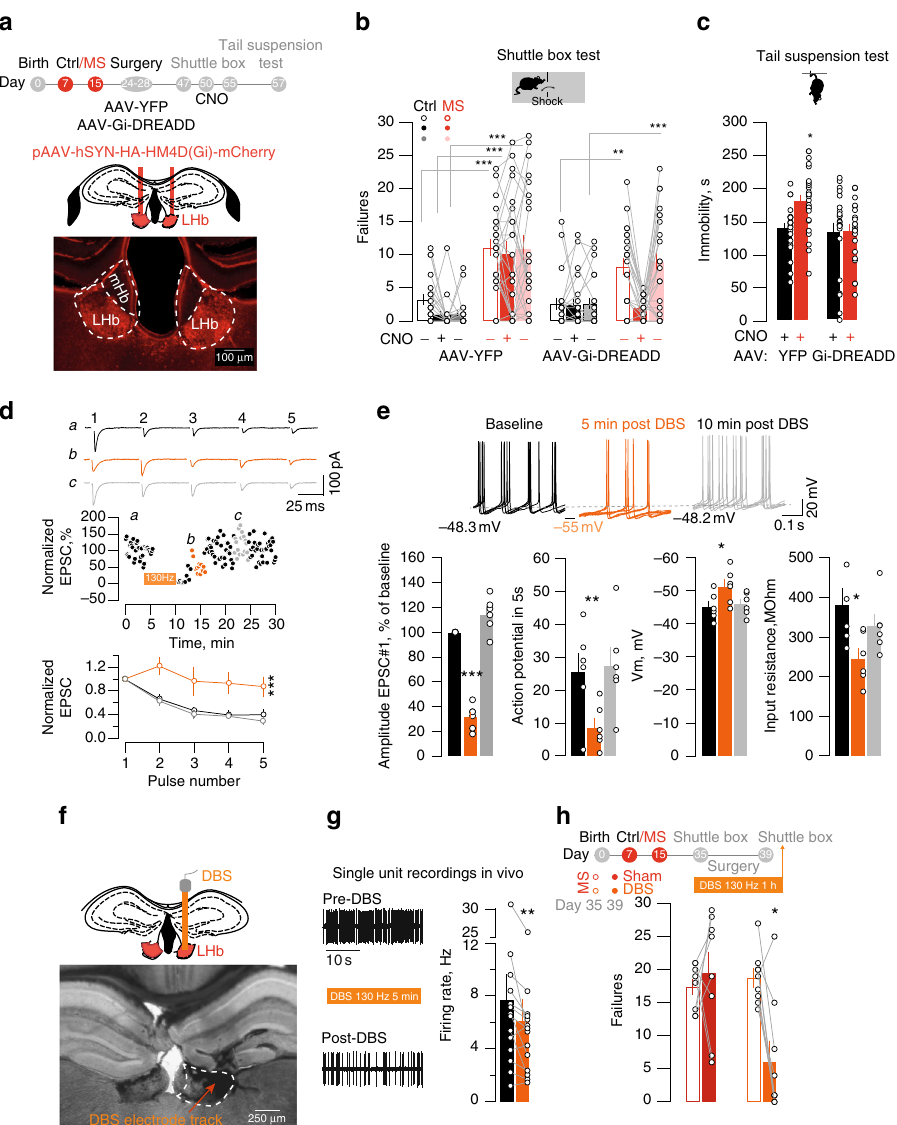
Fig. 4 Chemogenetic and DBS approaches reduce LHb activity and ameliorate MS-dependent depressive-like symptoms. a Schematic and image for Gi- DREADD LHb expression. b CNO effects on failures in the shuttle box (AAV-YFP, Ctrl vs. MS and AAV-Gi-DREADD, Ctrl vs. MS; n mice = 21/22/23/26; two-way ANOVA RM, interaction, F (6,176) = 3.29, ** p < 0.01). c Bar graph and scatter plot for TST immobility (AAV-YFP and AAV-Gi-DREADD, Ctrl vs. MS: n mice = 23/25/25/ 25; two-way ANOVA, interaction, F (1,94) = 4, * p < 0.05). d DBS effect on 1st EPSC and PPR (5 pulses, 20 Hz. Normalized eEPSC post-DBS, n mice = 2; n cells = 6; One-way ANOVA RM; F (1.23,6.13) = 99.65, *** p < 0.001; Normalized EPSCs, n mice = 2; n cells = 6; Two-way ANOVA RM; DBS effect, F (2,50) = 25.1, *** p < 0.001). e Sample I-clamp recordings (5 superimposed-sweeps), and DBS effects on action potentials, resting membrane potential and input resistance (Before vs. 5 min post-DBS vs. 10 min post-DBS, n mice = 2; n cells = 6: Action potential: F (1.29,6.49) = 13.5, ** p < 0.01; Vm: F (1.15,5.77) = 6.3, * p < 0.05; Ri: F (1.06,5.30) = 8.3, * p < 0.05; One-way ANOVA-RM) f DBS-electrode placement in LHb. g DBS-induced (130 Hz, 150 µ A) reduction of activity in vivo (Firing before vs. post-DBS, n mice = 4; n cells = 14; paired t-test, t 6 = 3.1; ** p < 0.01) h DBS-driven reduction of failures in the shuttle on MS mice (Sham vs. DBS; n mice = 8/9; Two-way ANOVA RM, interaction, F (1,15) = 9.476, ** p < 0.01). Scale bars = , 100 μ m a , 25 ms and 100 pA d